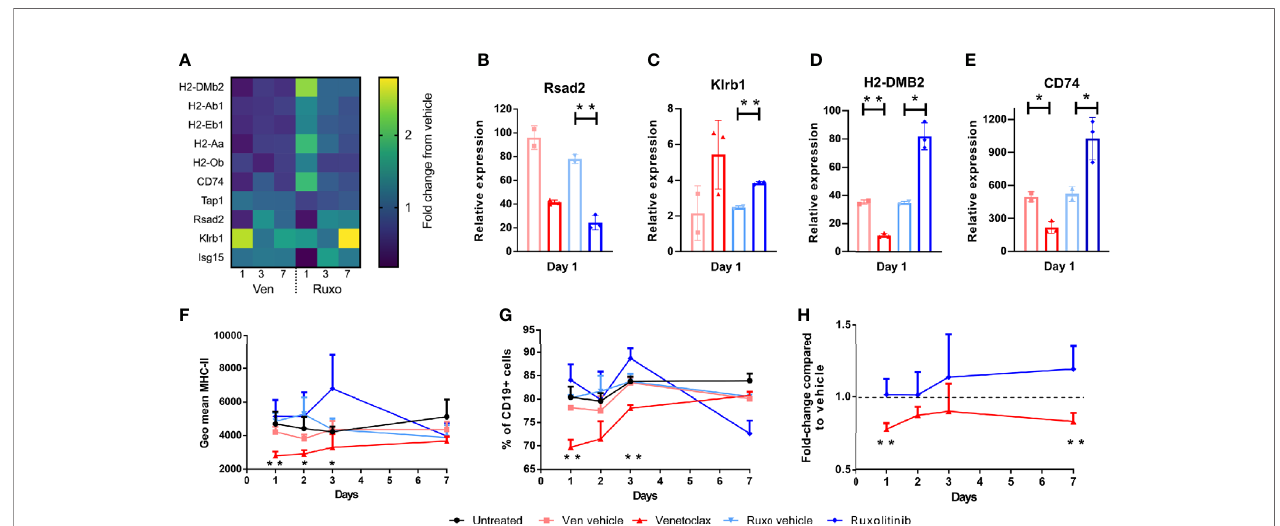
FIGURE 4 | Venetoclax and Ruxolitinib differentially affect MHC class-II and IFN-inducible gene expression. WT mice were treated with venetoclax or ruxolitinib, or their respective vehicle for two days. Mice (n=3-4/group) were killed on days 1, 3, and 7, and gene expression was determined from BM RNA using the NanoString Mouse PanCancer Immune Pro fi ling Panel. (A) Heat map of relative gene expression of H2-DMb2, H2-Ab1, H2-Eb1, H2-Aa, H2-Ob, CD74, Tap1, Rsad2, Klrb1 and Isg15 from venetoclax and ruxolitinib-treated mice. Relative expression of Rsad2, Klrb1, H2-DMB2 and CD74 (B – E) was compared between venetoclax or ruxolitinib-treated mice and their respective vehicle on day 1 post-treatment. The geometric mean of MHC-II expression on CD19+ B cells (F) , percentage of CD19+ B cells expressing MHC-II (G) , and the fold-change of MHC-II expression on total CD45+ BM cells from venetoclax or ruxolitinib-treated mice was compared to each vehicle control group (H) . Statistical analysis was performed using Mann-Whitney unpaired T test (B – E) , and unpaired T test (F – H) . *p < 0.05, **p <